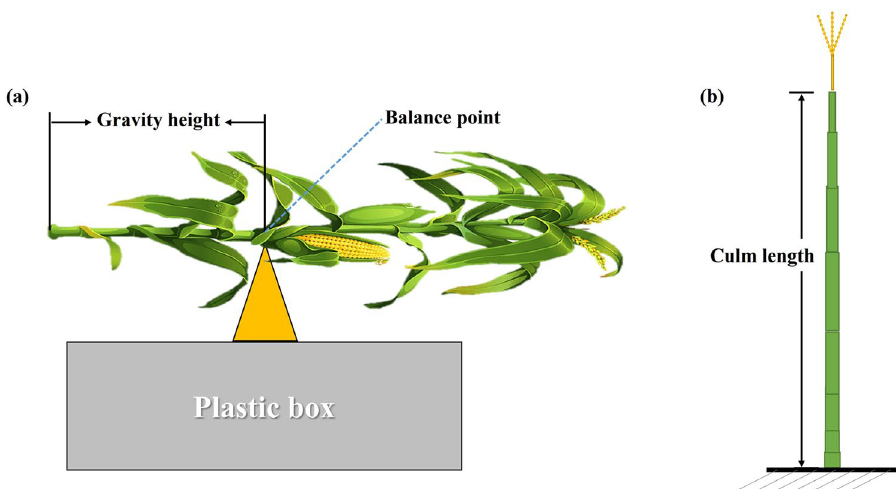
Figure 8. Schematic diagram of the method for measuring the height of the center of gravity ( a ) and culm length ( b ) of maize